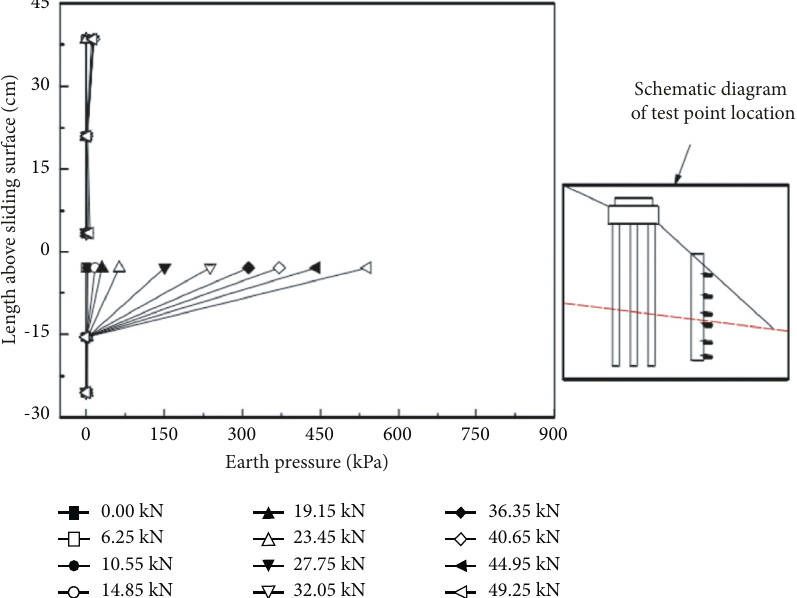
Figure 23: Relationship between soil pressure distribution and load in front of the front row antislide pile.